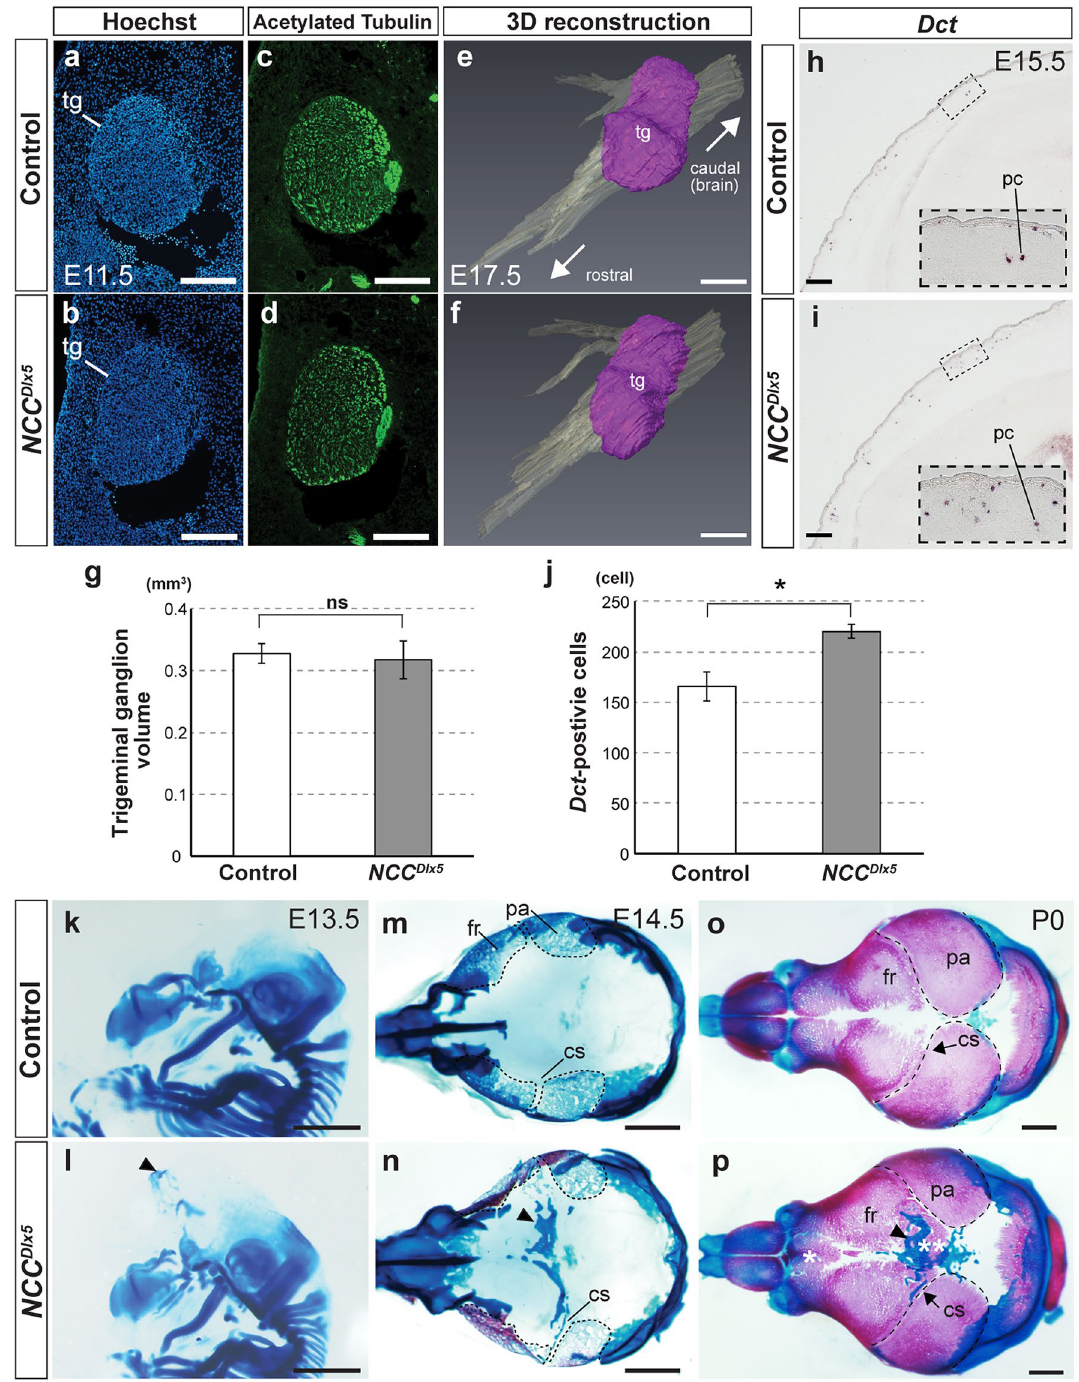
Figure 2. Dlx5 -augmentation in NCCs modifies NCC-derivatives. ( a – d ) Immunohistochemical staining for acetylated tubulin ( c , d ), nuclear counterstained by Hoechst ( a , b ) in the trigeminal ganglion. ( e , f ) 3-D reconstruction of trigeminal ganglion of the control ( e ) and the NCC Dlx5 ( f ). ( g ) Statistical analysis of the trigeminal ganglion volume measured after reconstruction. ( h , i ) Dct localization, a pigment cell specifier, by ISH on frontal section of E15.5 heads. Insets in ( h , i ) are high magnified images of the boxed areas. ( j ) Statistical analysis of the number of Dct -positive cells. ( k – p ) Skeletal staining for cartilage (alcian blue) and bone (alizarin red). Lateral views at E13.5 ( k , l ), dorsal views (skull base removed) of calvaria at E14.5 ( m , n ) and P0 ( o , p ) of skeletal staining in the control and the NCC Dlx5 . Ectopic cartilage is induced in the NCC Dlx5 (arrowheads in l , n , p ) from E13.5. The developing heterotopic bone overlaps with the ectopic cartilage (double asterisks in p ) at P0. Dashed lines contour cranial bones. Two-tailed t-test; *p < 0.05; ns, not significant. cs, coronal suture; fr, frontal bone; pa, parietal bone; pc, pigment cell; tg, trigeminal ganglion. Scale bar; 200 μm ( a – d , h , i ), 500 μm ( e , f ) and 1 mm ( k – p